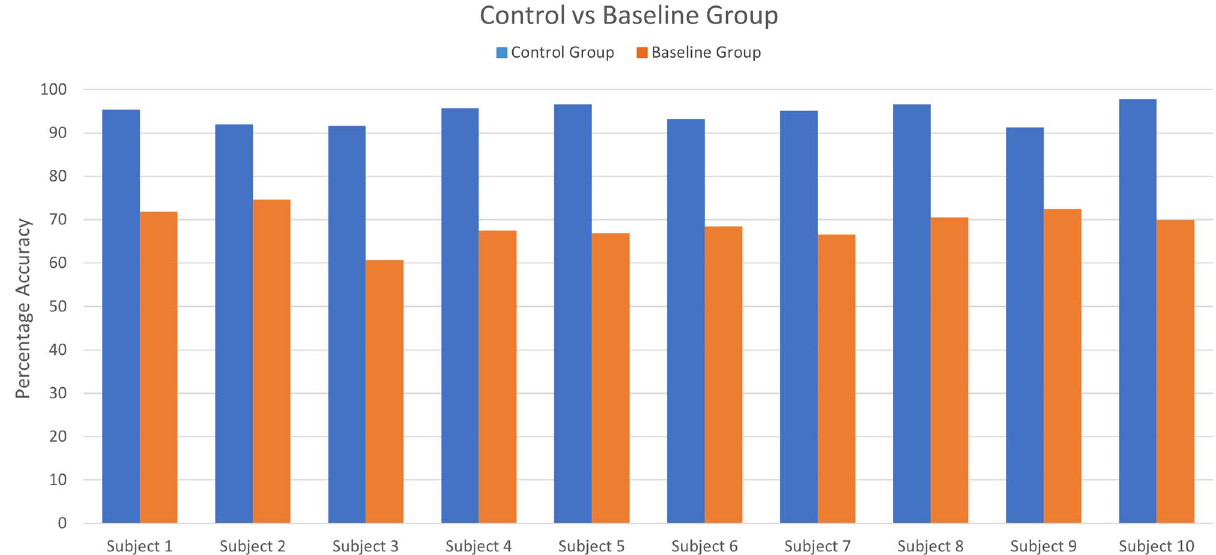
Figure 7. The comparison between accuracies acquired on control and baseline group via learned CNN and randomly initialized CNN